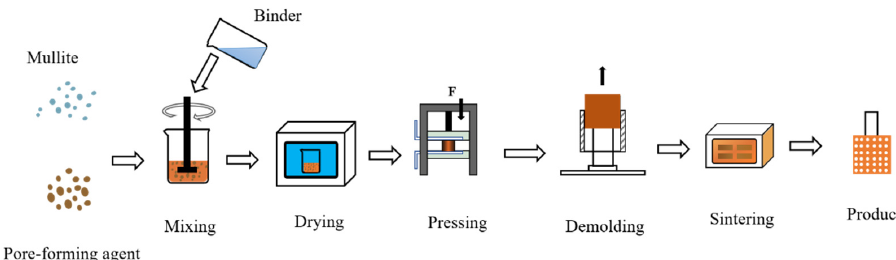
Figure 1. The manufacturing process of a porous nozzle.